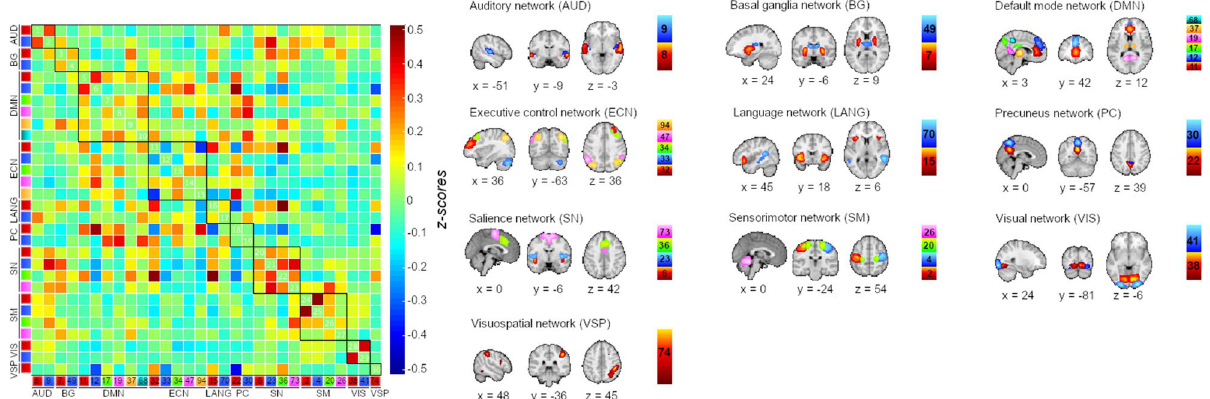
Figure 2. Group IC analysis maps and its functional connectivity. In the left, correlation matrix between the 30 selected IC, black squares in the matrix represent correlations between IC within the same network (intra- network connectivity). In the right, spatial representation of the selected IC divided according to the Findlab atlas 40 . IC maps and matrix were obtained from the GIFT toolbox 22